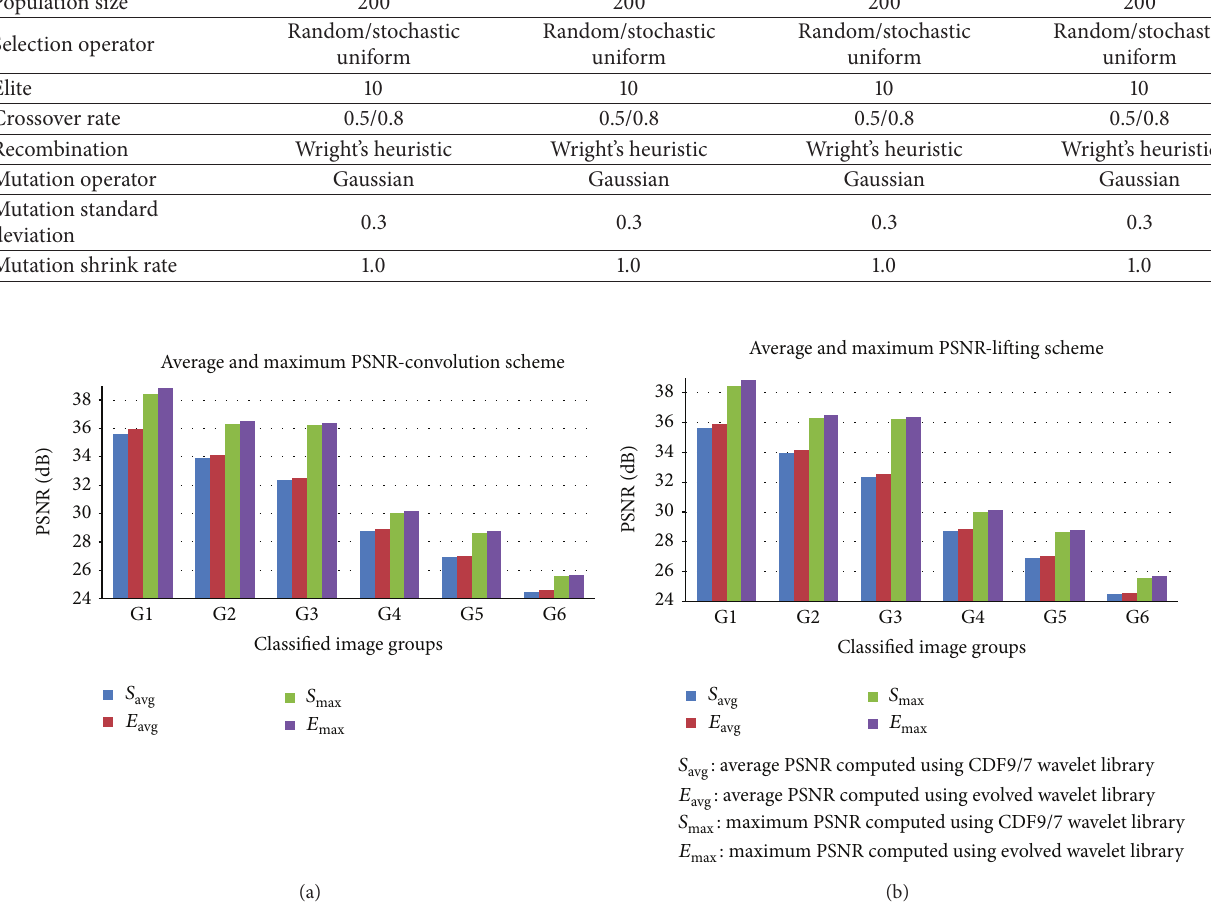
Figure 10: Comparison of quality metrics of the reconstructed image using CDF 9/7 and evolved filter coefficients; (a) average and maximum PSNR for convolution scheme; (b) average and maximum PSNR for lifting